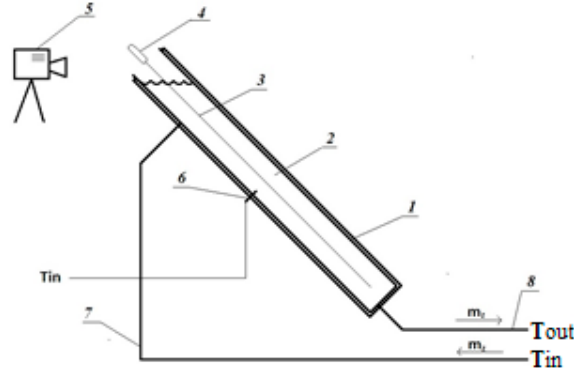
Figure 9. The heat transfer test stand diagram. 1—thermally insulated tank; 2—heating fluid (wa-